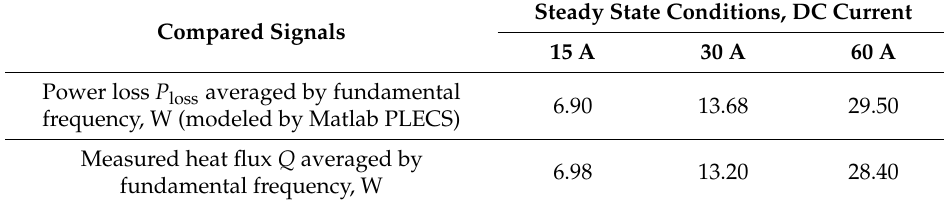
Table 4. Comparison of the heat flux test results with the power loss defined by numerical modeling in Matlab PLECS.